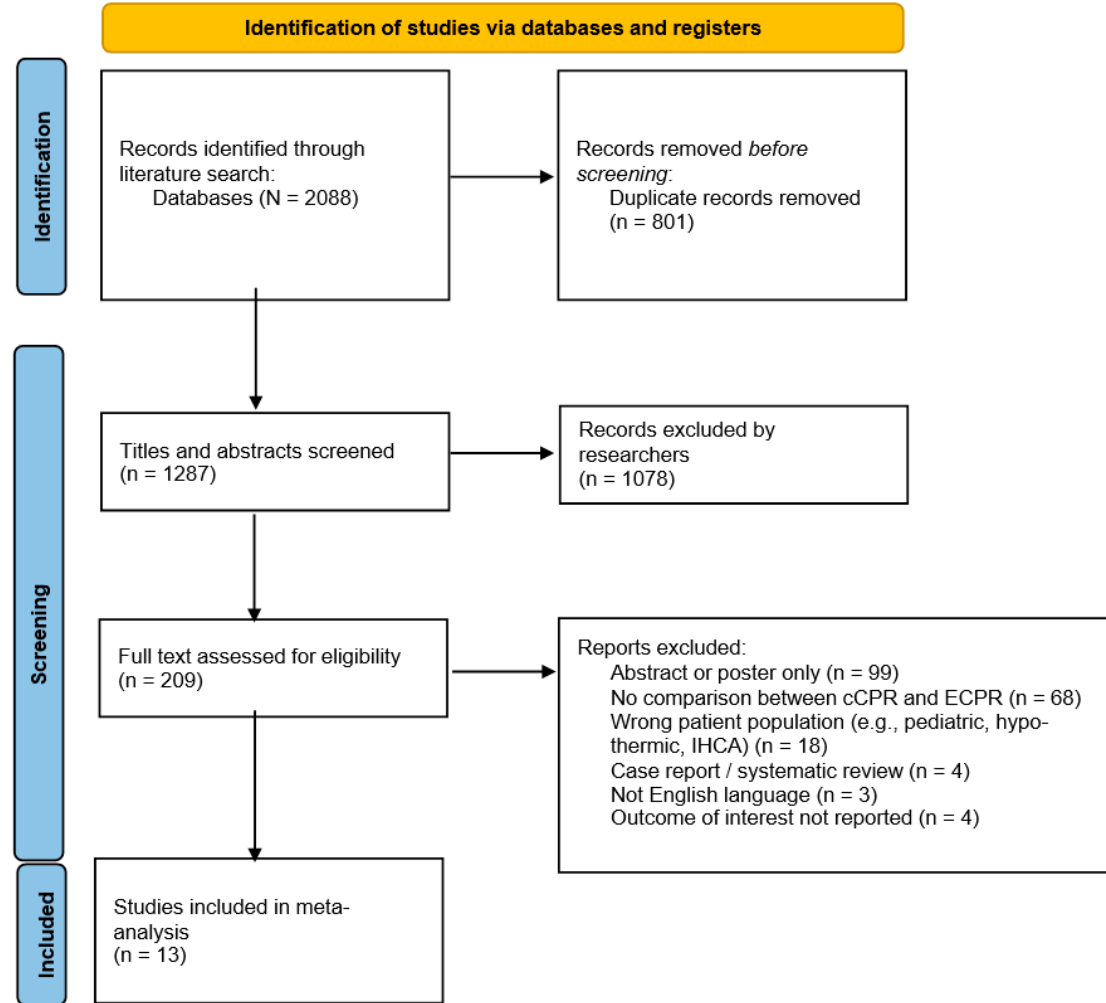
Figure 1. Flow diagram for study selection. Abbreviations: cCPR, conventional cardiopulmonary resuscitation; ECPR, extracorporeal cardiopulmonary resuscitation; IHCA, in-hospital cardiac arrest. Adapted from the PRISMA 2020 statement [10].